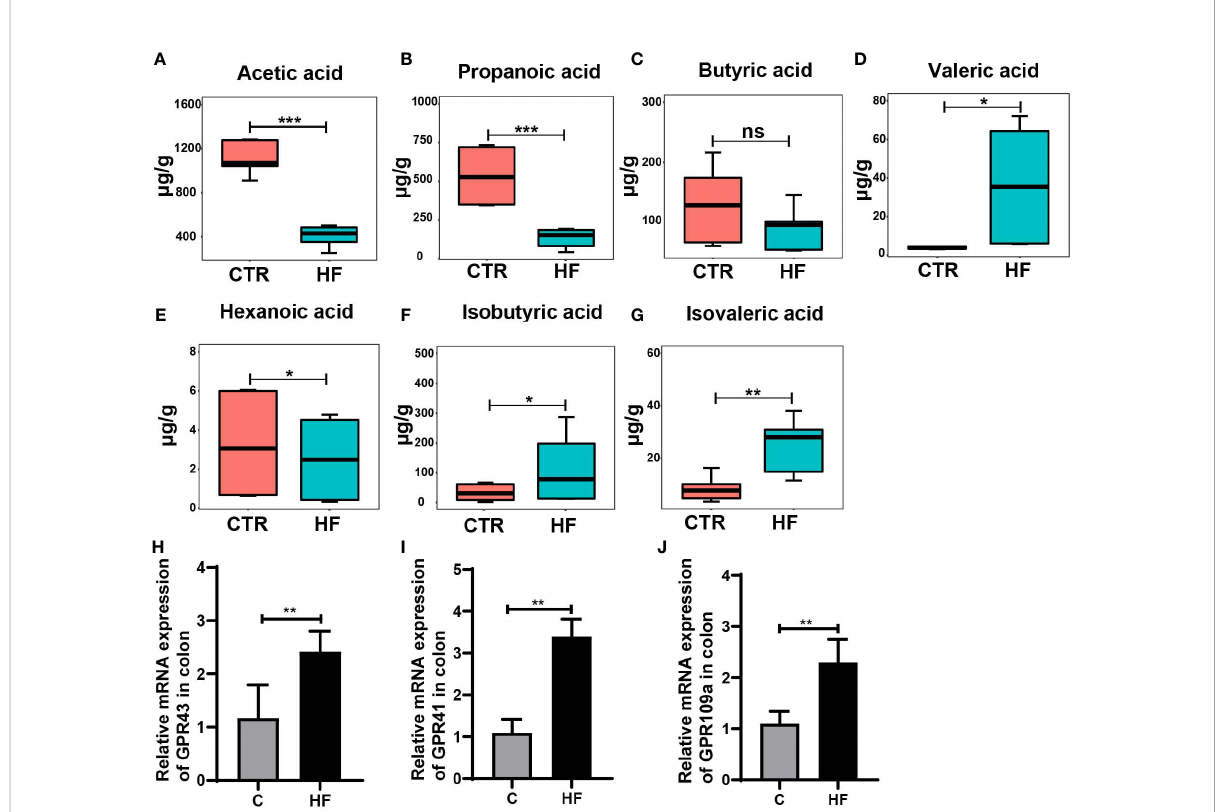
FIGURE 4 HFD alters the levels of fecal SCFAs and their related receptors in the colon in the rats with obesity-induced precocious puberty. (A) The content of acetic acid in fecal. (B) The content of propanoic acid in fecal. (C) The content of butyric acid in fecal. (D) The content of valeric acid in fecal. (E) The content of hexanoic acid in fecal. (F) The content of isobutyric acid in fecal. (G) The content of isovaleric acid in fecal. (H) The gene expression of GPR43 in the colon. (I) The gene expression of GPR41 in the colon. (J) The gene expression of GPR109a in the colon. Fecal SCFAs levels were detected by GC-MS. n = 6 per group for rat samples. *P<0.05; **P<0.01; ***P<0.001. ns, not signi fi